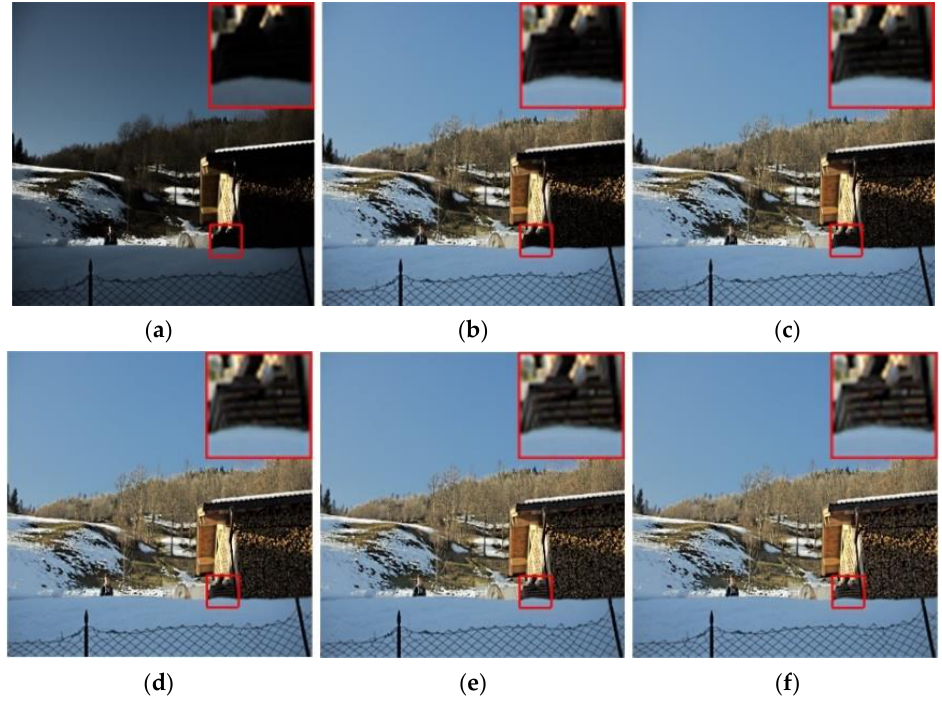
Figure 23. Enhancement results under different γ in Equation (11). ( a ) Original image; ( b ) γ = 1; ( c ) γ = 1.5; ( d ) γ = 2.2; ( e ) γ = 3; ( f ) γ =